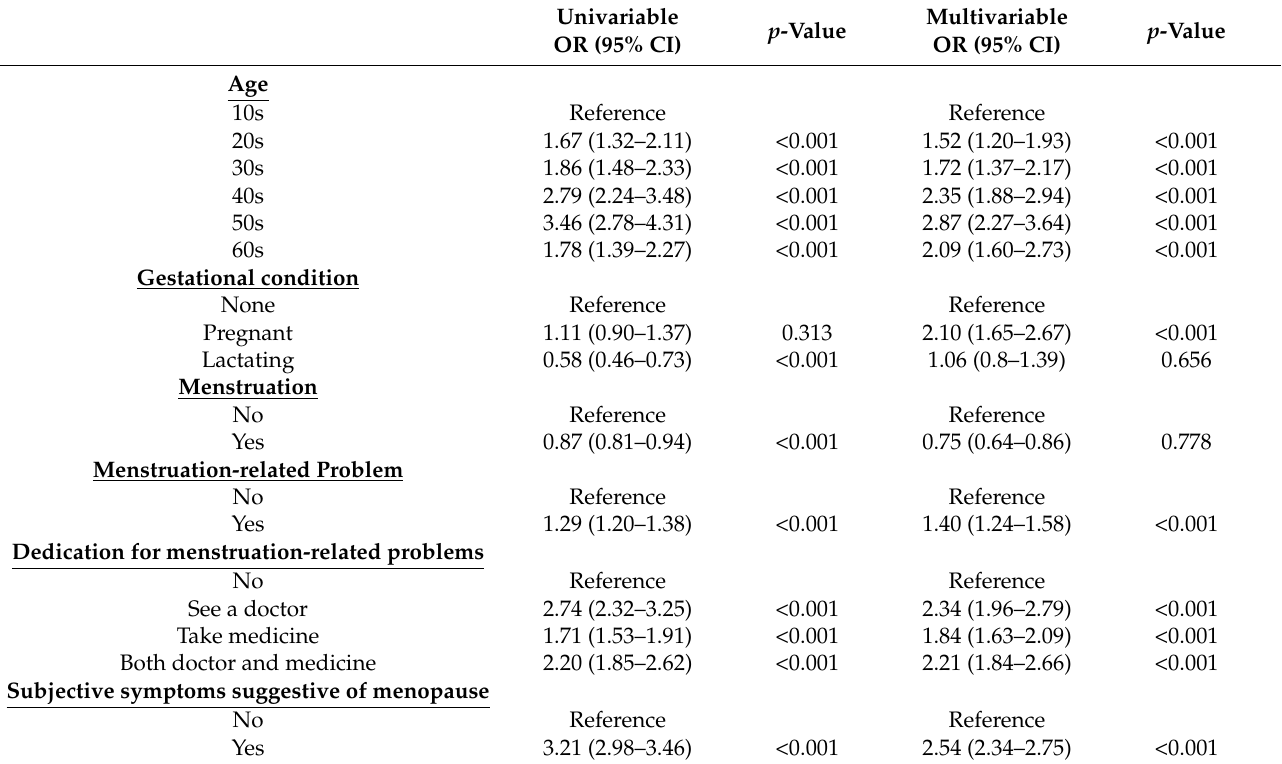
Table 3. Factors associated with estrogen-like supplement